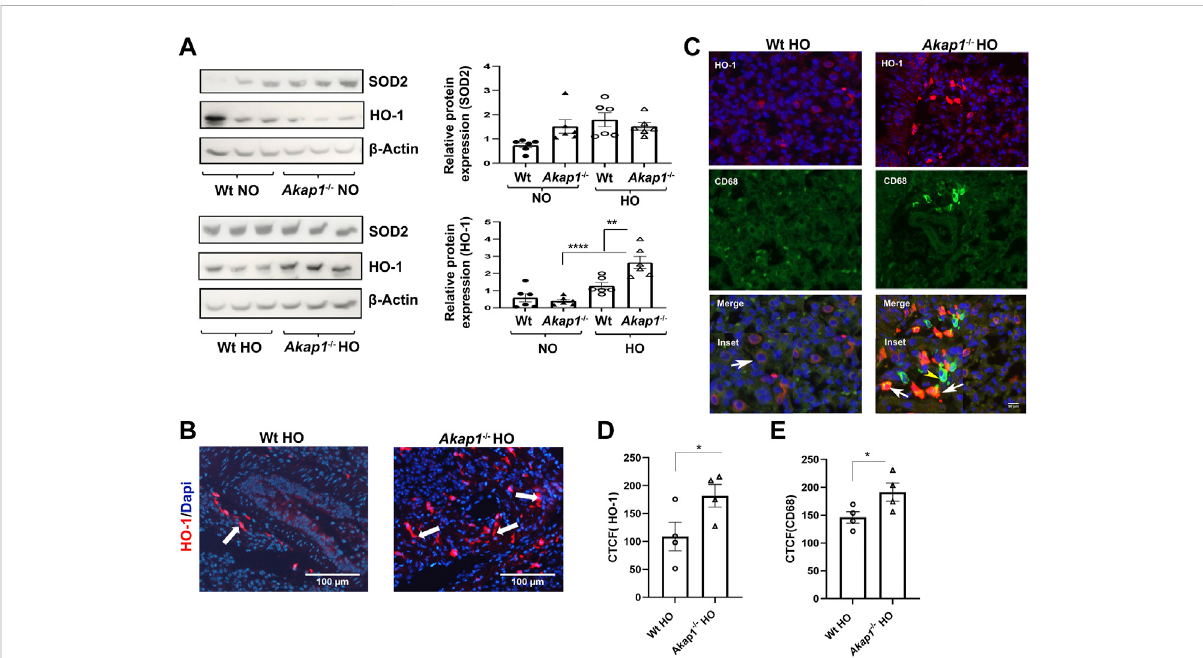
FIGURE 4 Oxidativestressincreasesin Akap1 − / − miceexposedtohyperoxia. (A) WesternblotanalysesofSOD2andHO-1expressioninthelysatesfrom Wt and Akap1 − / − miceexposedtonormoxiaorhyperoxia.SOD2 andHO-1expressionwerequanti fi edafter normalizationwith β -Actin(loading control). ** p < 0.01 Akap1 − / − hyperoxia versus Wt hyperoxia. **** p < 0.0001 Akap1 − / − hyperoxia versus Akap1 − / − normoxia. n = 6 mice per group. Two-tailed unpaired Student ’ s t-test. (B) Representative images from IF analysis shows increased expression of HO-1 (white arrows) in the lung section of Akap1 − / − hyperoxia versus Wt hyperoxia mice. Magni fi cation: ×400. Scale bar: 100 μ m. (C) Representative images from IF analyses of HO-1 (red) and CD68 (green) in lung sections derived from Wt and Akap1 − / − mice exposed to hyperoxia. Arrowheads indicates the HO-1 positive cells co-labelled with CD68 (Macrophage marker). Arrow shows HO-1 expressing cells without CD68 expression. Nuclei stained with DAPI (blue). Magni fi cation: ×400, scale bar: 50 μ m. (D) Quantitative analysis of HO-1 expression is represented as corrected total cell fl uorescence (CTCF). HO-1 expression in the lung sections of Akap1 − / − hyperoxia versus Wt hyperoxia. n = 4 mice per group. Data represented as mean ± SEM. * p < 0.05 versus Wt hyperoxia. UnpairedStudent ’ st-test. n =4pergroup. (E) QuantitativeanalysisofCD68 + expressionisrepresentedasCTCF.CD68 + staininginthelungsections of Akap1 − / − hyperoxiaversus Wt hyperoxia.n=4micepergroup.Datarepresentedasmean±SEM.* p < 0.05 Akap1 − / − hyperoxiaversus Wt hyperoxia. Unpaired Student ’ s